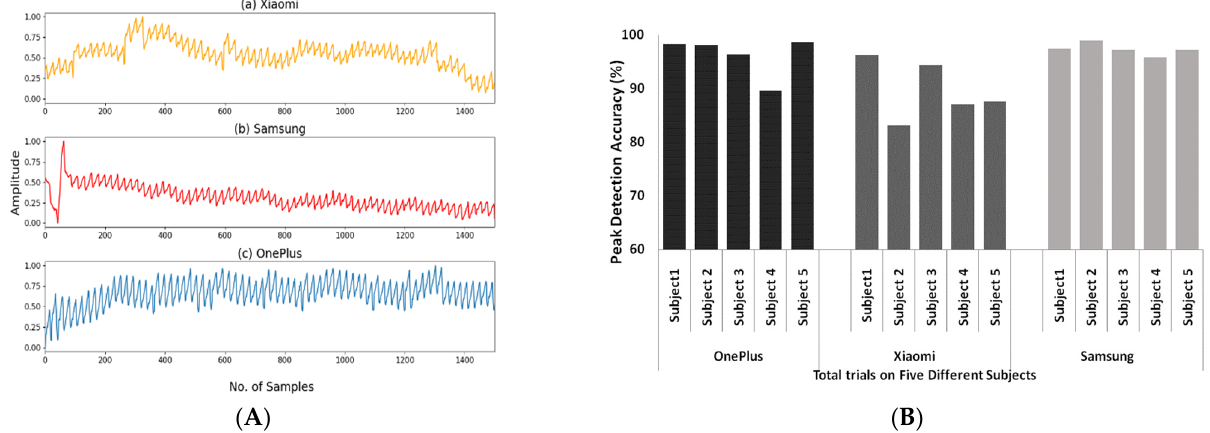
Figure 2. ( A ) Normalized Photoplethysmography (PPG) signal acquired using ( a ) Xiaomi Redmi Note 5 Pro, ( b ) Samsung Galaxy Note 8, and ( c ) OnePlus 6T phones. ( B ) Performance evaluation on PPG signal acquisition by the three smartphones.